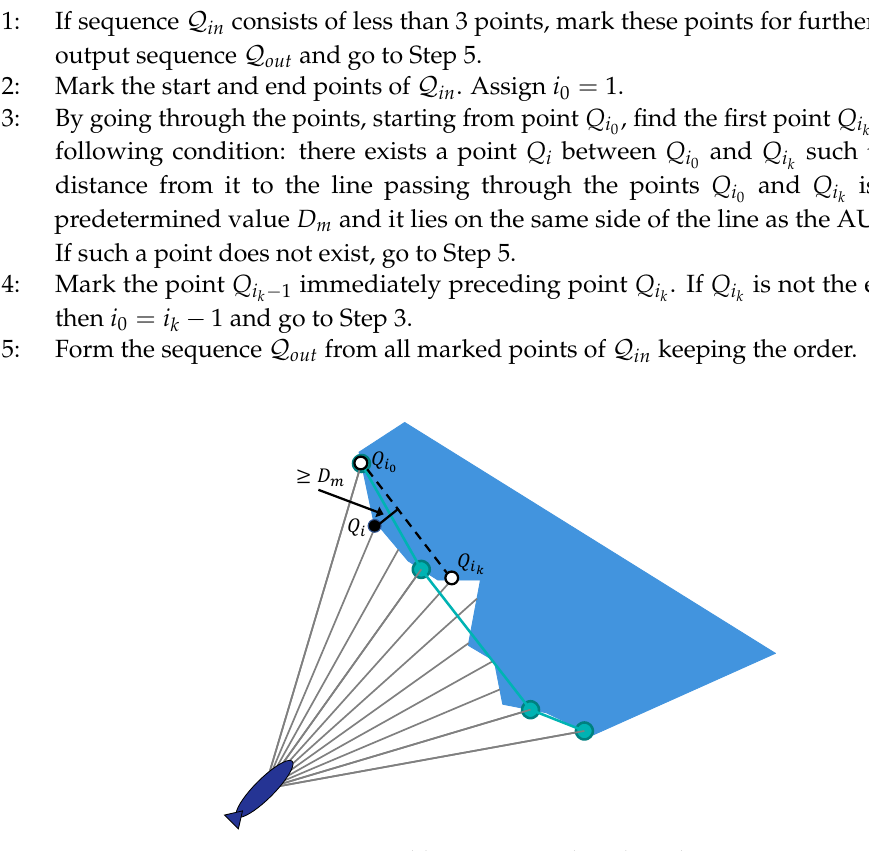
Figure 4. Building a convex obstacle